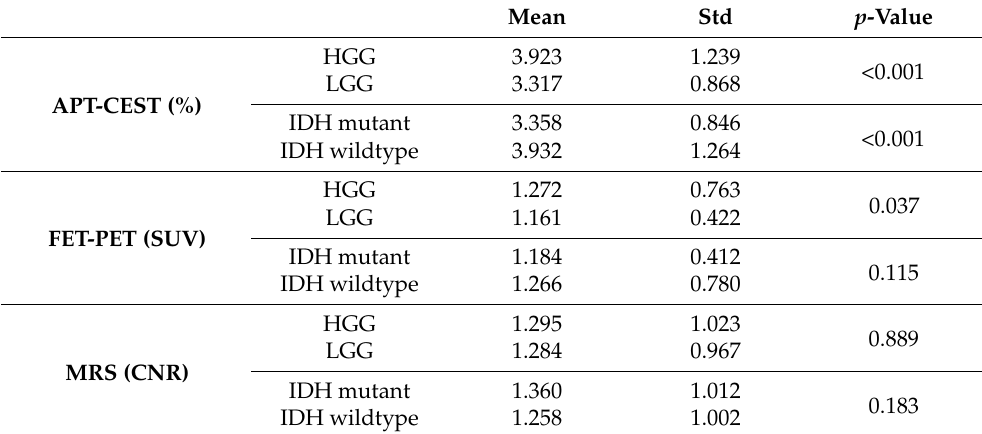
Table 2. Pixel-wise comparison of APT-CEST, MRS and FET-PET according to tumor grade and IDH mutation. Mean Std p -Value HGG 3.923 APT-CEST (%)